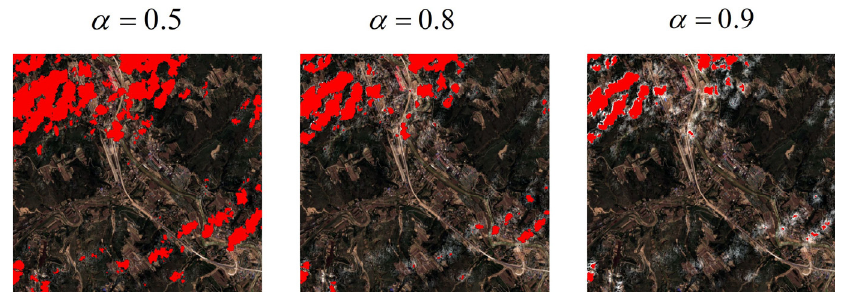
Figure 8. Setting different cloud opacity thresholds and overlaying the cloud removal results. Effectively improves the application of cloud removal results by masking the areas with lower confidence regions and taking α = 0.5 in this image yields optimal